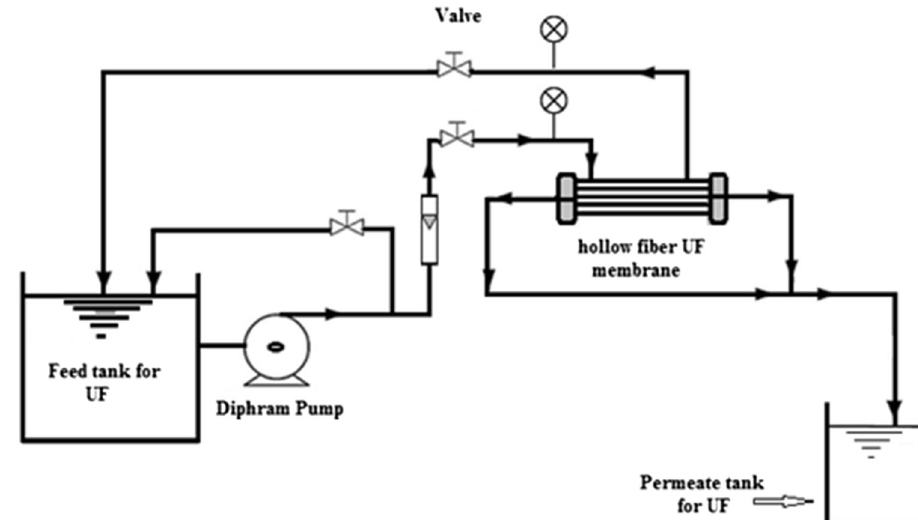
Fig. 1 Schematic diagram of the UF